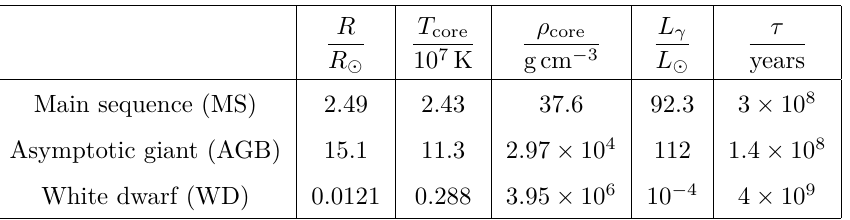
Table 1 . Properties of the benchmark star we simulate at various points throughout its lifetime. We note that L is the visible luminosity of the star into SM photons (as opposed to dark photons). γ The last column τ is the time the star spends in each phase. For the white dwarf phase, this marks the age at which it reaches M = 14 . 7 , populating the faintest bins in the measured WDLF, see bol figure